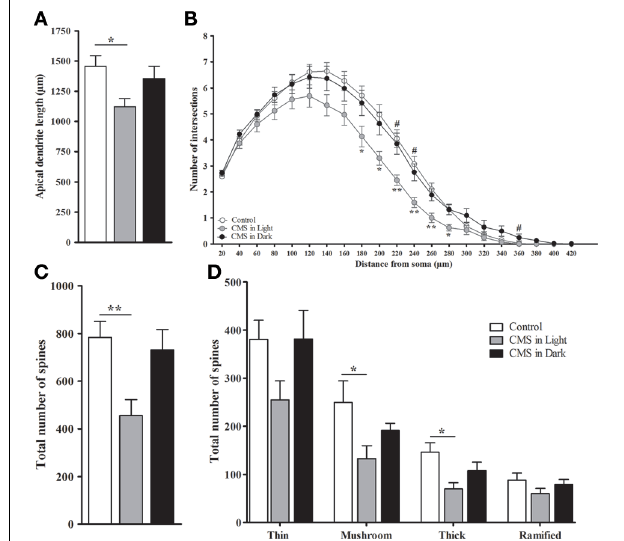
FIGURE 6 | Morphometric analysis of dendritic arborizations in the hippocampal dentate gyrus. (A) Total dendritic length. (B) Sholl analysis-derived distribution of dendrites. (C) Total number of spines. (D) Total number of different types of spines. Controls, n = 20, each CMS group, n = 14; ∗ P < 0 . 05. ∗∗ P < 0 . 01. # P < 0 . 05. Data presented as mean ± s.e.m. ∗ and ∗∗ indicate significant differences between the CMS-Light and the CON group. # indicates a significant difference between the CMS-Light and the CMS-Dark